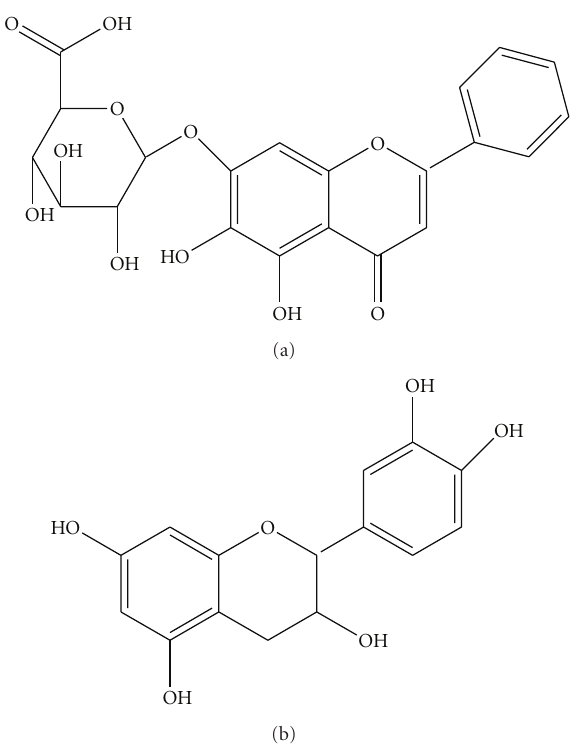
Figure 1: Flavocoxid (a) baicalin and (b)